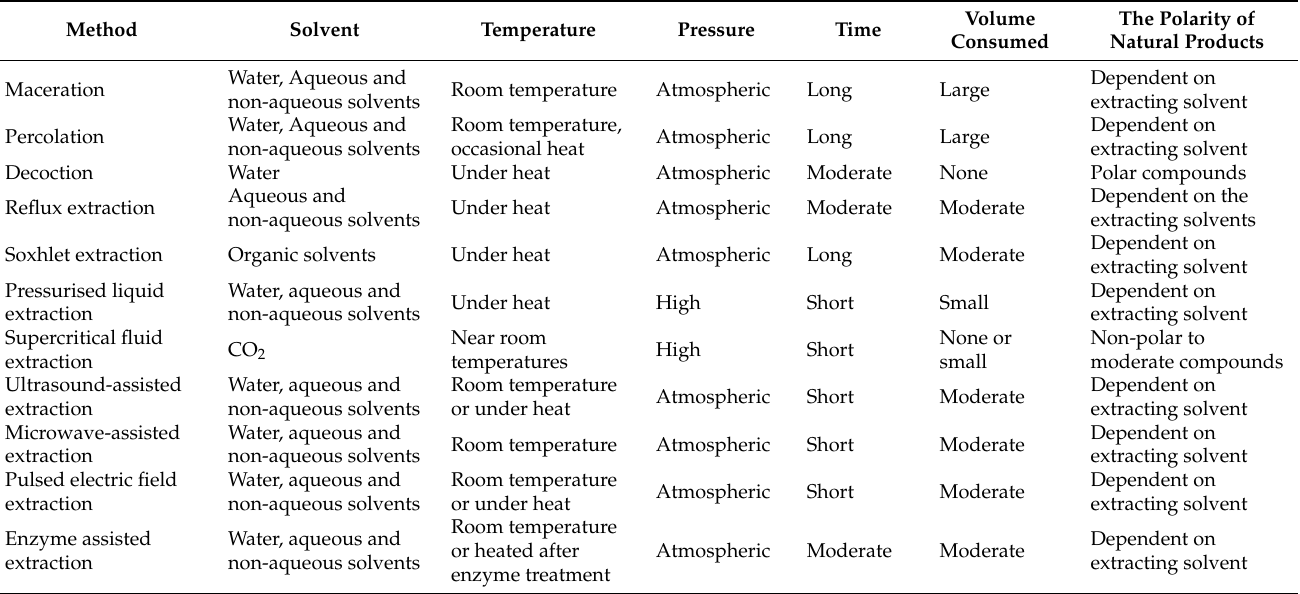
Table 4. Extraction methods used in biomass extractions